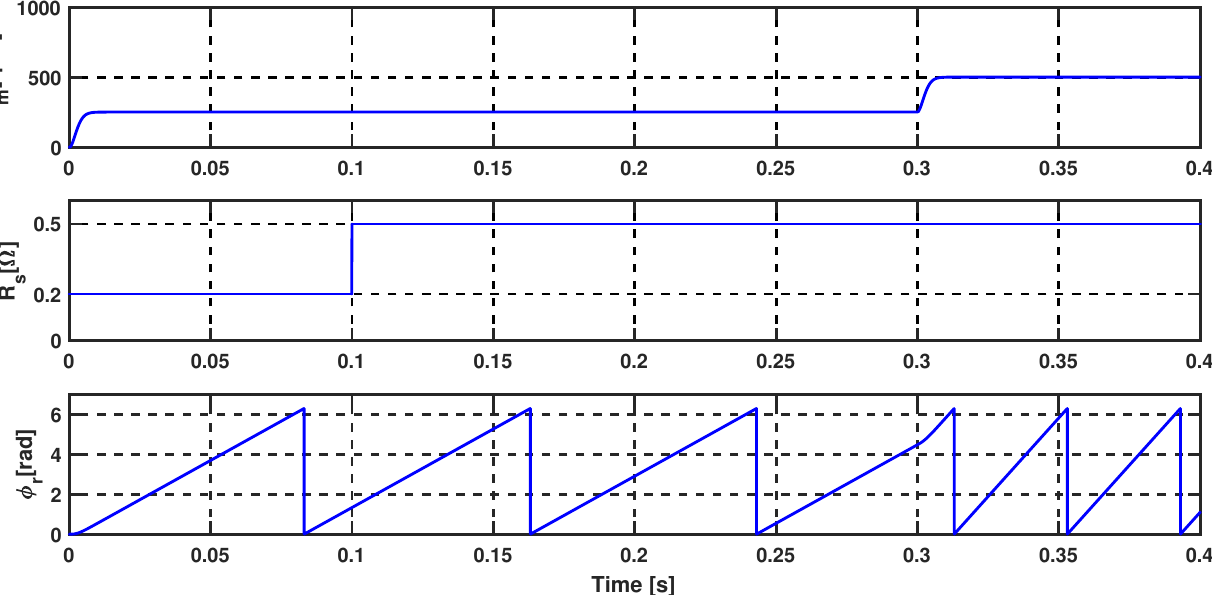
Figure 12. Simulation results of multiple vector 2VV FCS-MPC at step change in the PMSM resistance R s (from top): Speed ω m , resistance R s , and rotor angle φ r .